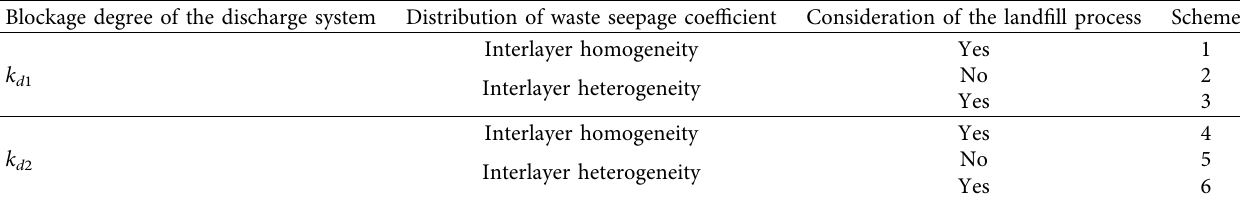
Table 2: The research scheme